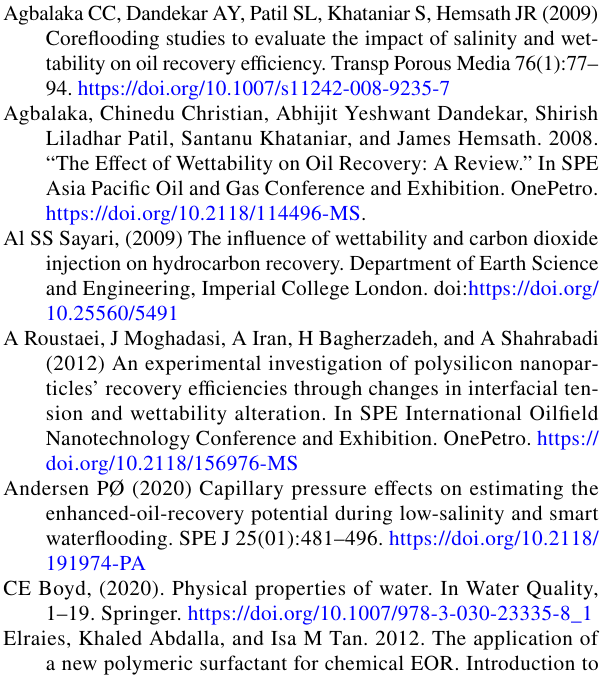
tability on oil recovery efficiency. Transp Porous Media 76(1):77– 94. https:// doi. org/ 10. 1007/ s11242- 008- 9235-7